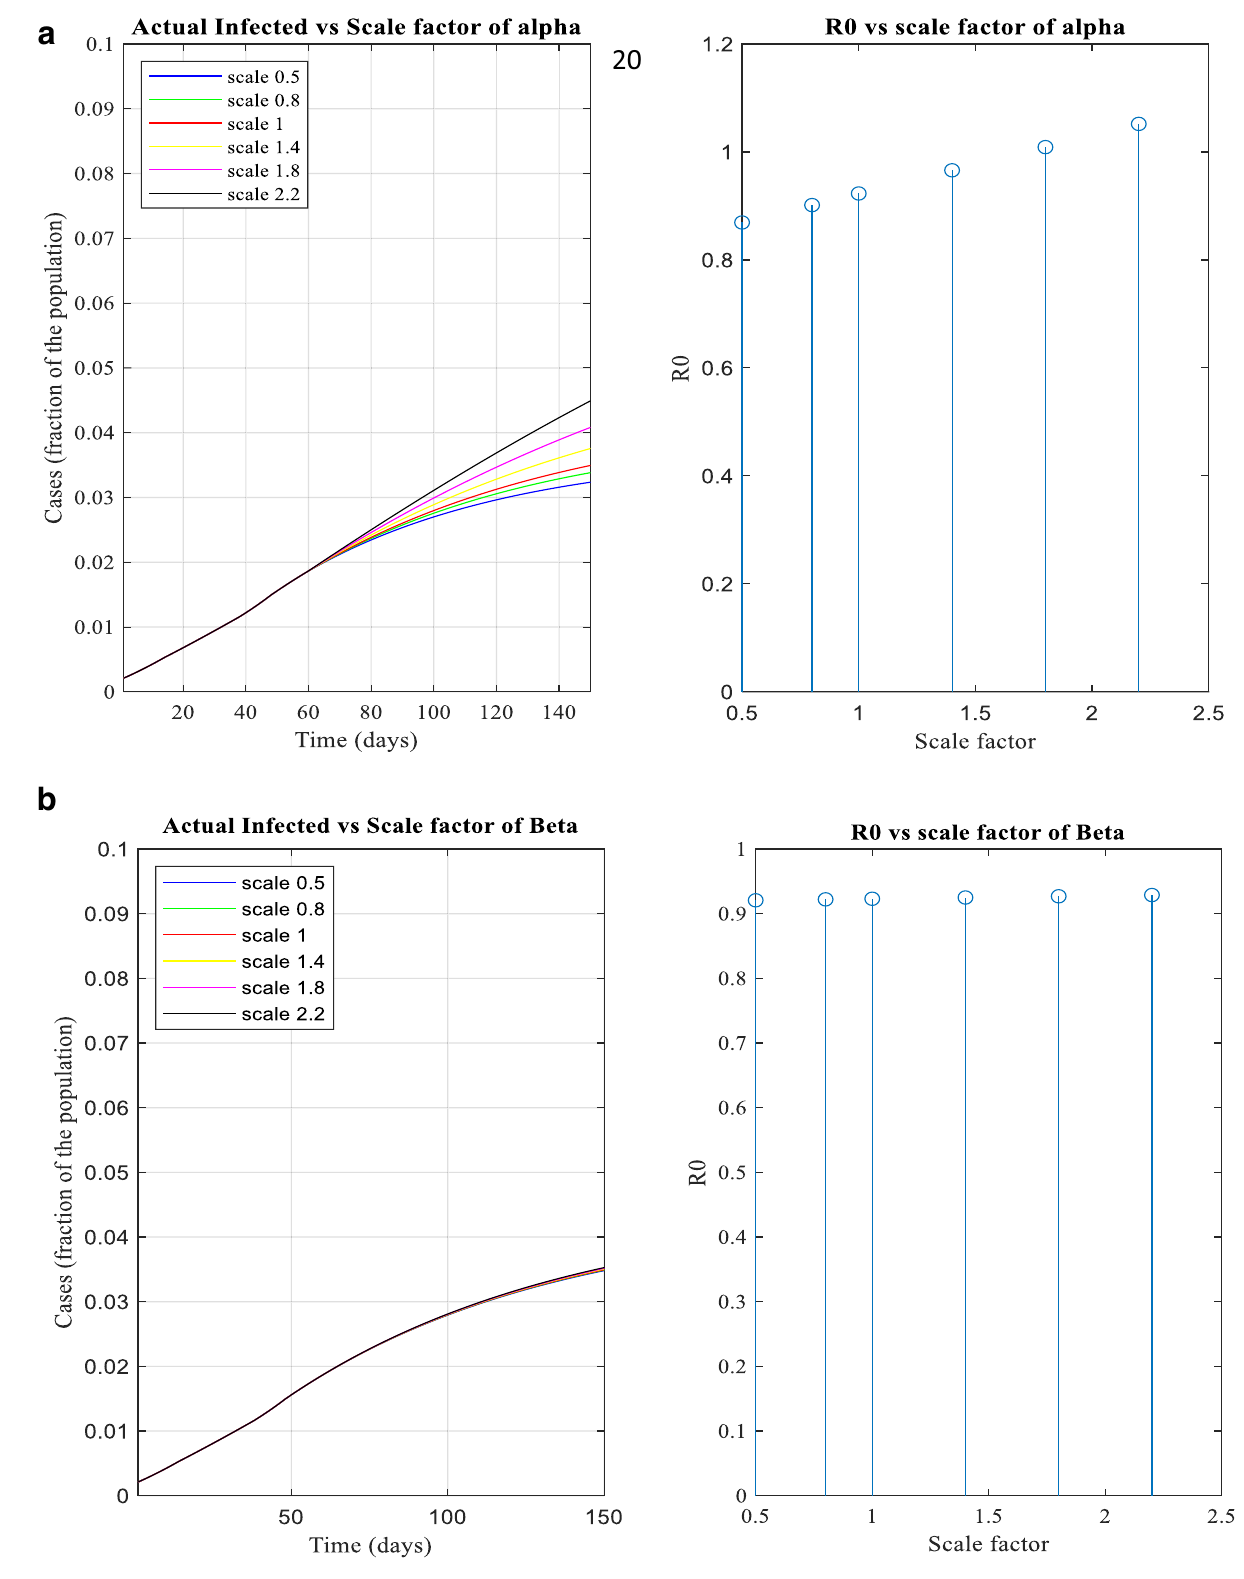
Figure 8. ( a - d ) The infected and R 0 versus scale factor of α, β, γ and